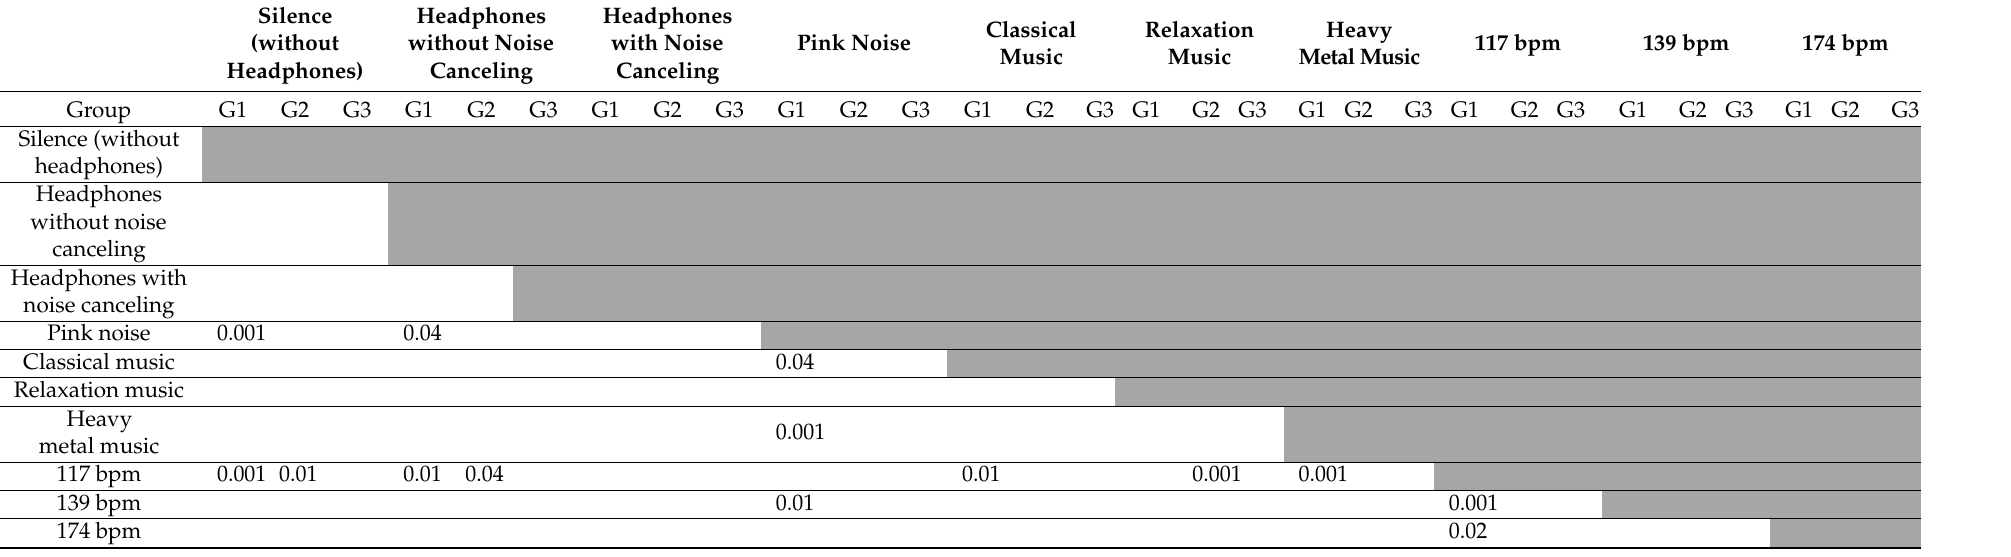
Table 1. Within-group differences of the measurement conditions: significant p -values of the Wilcoxon-matched-pairs test including Bonferroni-Holm correction after a significant Friedman test of the measurement condition per group. The table summarizes all individual Friedman tests and has to be read as following: if a p value is mentioned a significant difference is observed within the specific group between the condition mentioned in the column and the condition mentioned in the row. Only significant p -values are